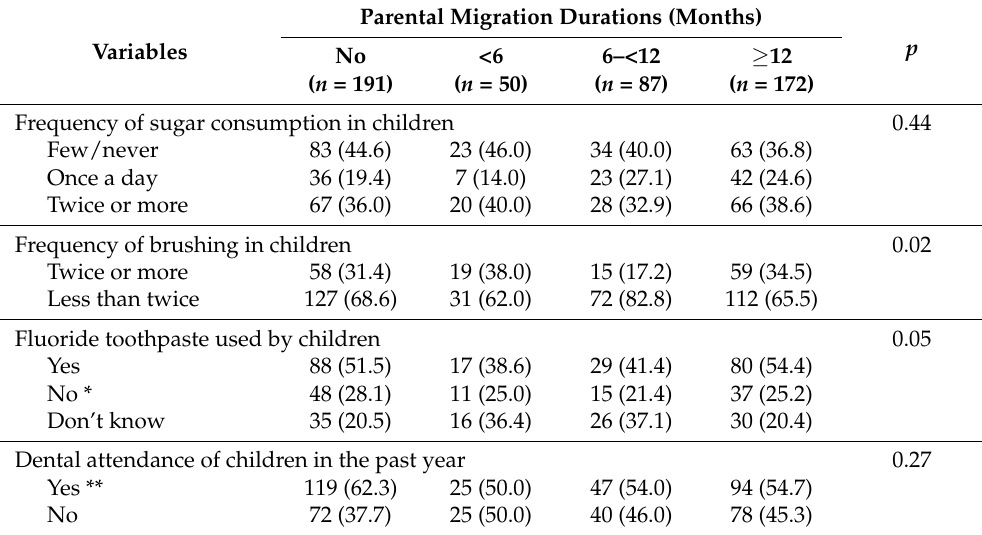
Table 2. Crude association between oral health behaviours and parental migration durations, n (%).